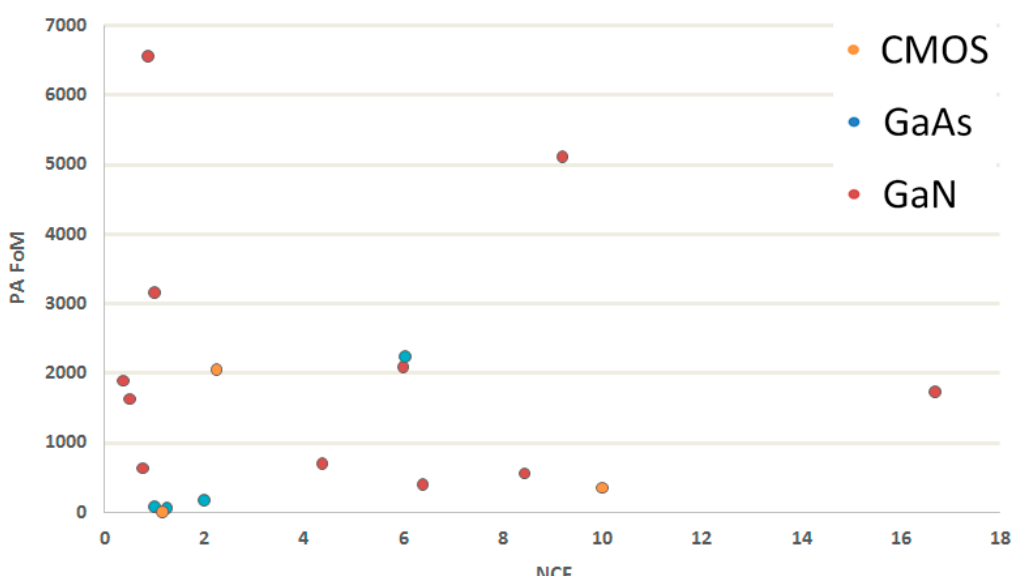
Figure 3. PA FoM and normalized complexity factor plot. Designs with high PA FoM and low NCF are preferred. The orange plots represent CMOS DPAs, blue plots represent GaAs DPAs, and red plots represent GaN DPAs. Table 3. Reported DPAs with PA FoM and normalized complexity factor.